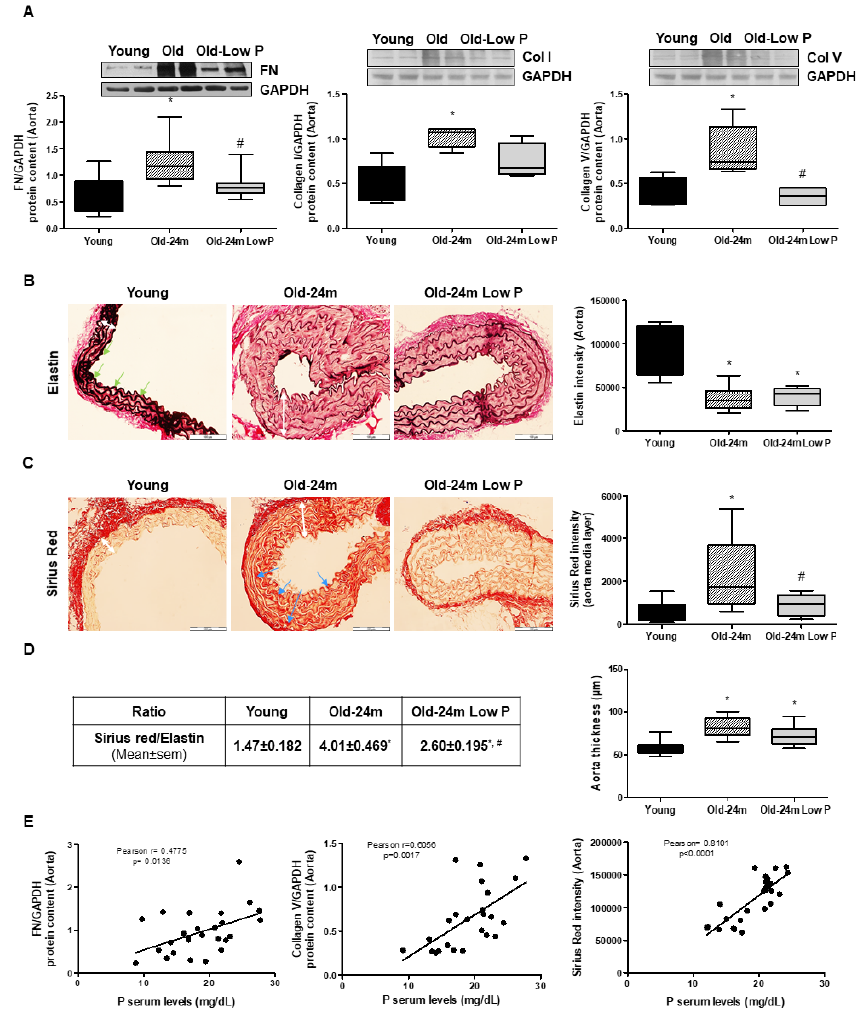
Figure 2. Hyperphosphatemia induces fibrosis in aorta from old mice. Male C57Bl6 mice from 5 month old (Young, closed bars), 24 month old fed with normal diet (Old-24 m, striped bars) and 24 month old mice fed with a low phosphate diet for the last 3 months (Old-24 m Low P, grey bars) were used. ( A ) Aorta tissue was isolated from mice to evaluate fibronectin (FN), collagen I (Col I) and collagen V (Col V) protein expressions by Western blot. A representative Western blot is shown above with the densitometric analysis below. ( B , C ) Elastin staining ( B ) and Sirius red staining ( C ) of the aorta from mice (40 × ) is shown on the left of each panel with the graph of densitometric analysis on the right. Scale bar, 100 µ m. Green arrows indicate elastin expression in black, blue arrows indicate Sirius red expression in red and white arrows indicate the thickness of the aorta wall. ( D ) On the left, a table with the ratio between Sirius red and Elastin expression of each group of mice is shown, and a graph with the densitometric analysis of aorta thickness from all groups is shown on the right of the panel. ( E ) Graphs of correlations between P serum levels and different parameters of fibrosis are shown: P levels and FN expression (Pearson r = 0.4775, p = 0.0136), P levels and Col V expression (Pearson r = 0.6056, p = 0.0017) and P levels and Sirius red expression (Pearson r = 0.8101, p = 0.0001). Values are the mean ± SEM of 10 mice per group, * p < 0.05 vs. young, # p < 0.05 vs. Old-24